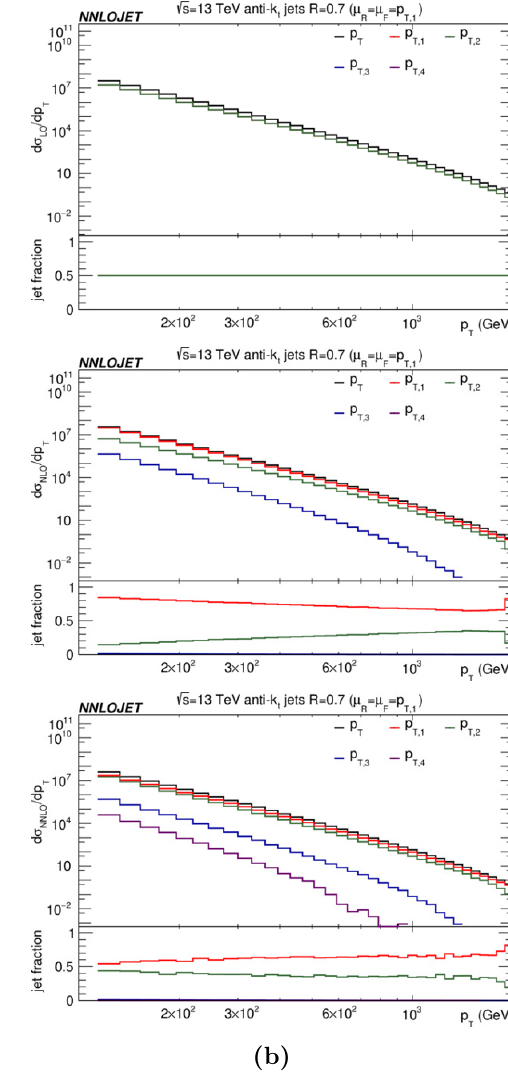
Figure 7 . Breakdown of single jet inclusive cross section integrated over rapidity into contributions from (cid:12)rst, second, third and fourth jet at (i) LO, (ii) NLO and (iii) NNLO evaluated for (cid:22) = p T ; 1 for jet cone sizes (a) R = 0 : 4 and (b) R = 0 :